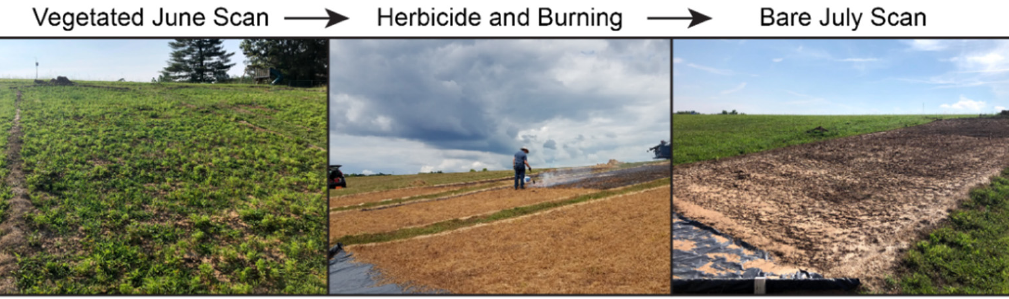
Figure 2. Vegetation removal process.